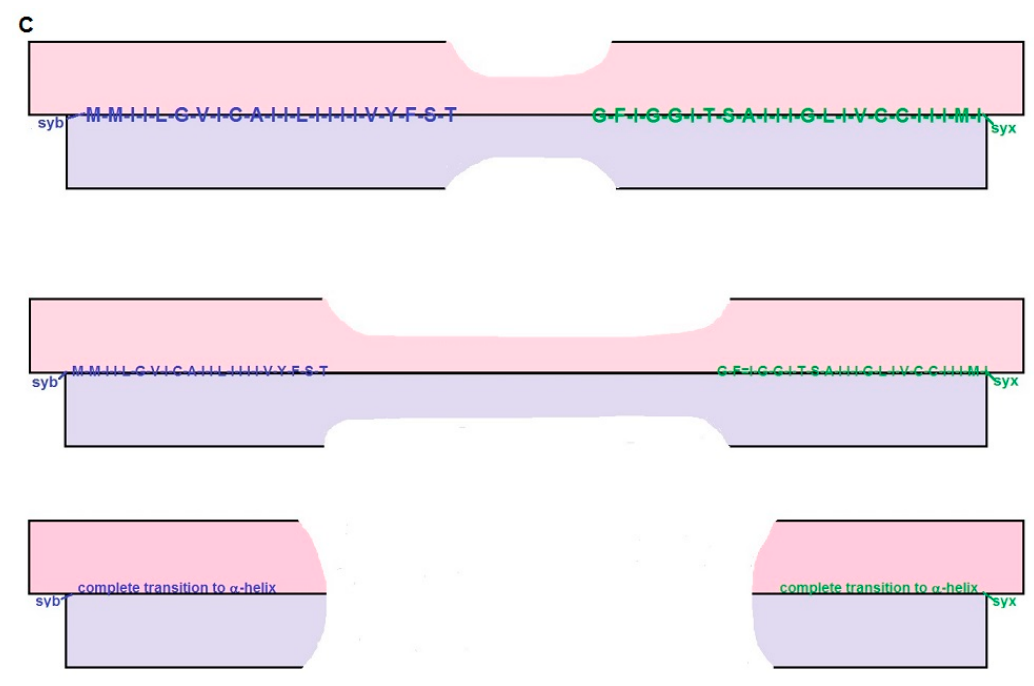
Figure 3. Fusion sequence for the BAT model. ( A ) The upper panel shows a cross-sectional view of a partial transition to α -helix of the syb (in blue) and syx (in green) with a nascent, central fusion pore. The lower panel shows full helical transition of the syb and syx pairs with an expanded fusion pore. In both panels the arrowhead represents the region that has transitioned to helix ( B ) This is a cross-section of the partial and full transition to α -helix which depicts the shortening of the syb (in blue) and syx (in green) and the coating of the ends of these polypeptides by membrane lipids. The shortening is represented by the use of smaller font for the membrane-embedded sequences of syb and syx ( C ) In contrast to the sequence in A&B, the transition to full fusion may include a hemi-fusion intermediate that resolves to full fusion via mechanisms discussed in the text.